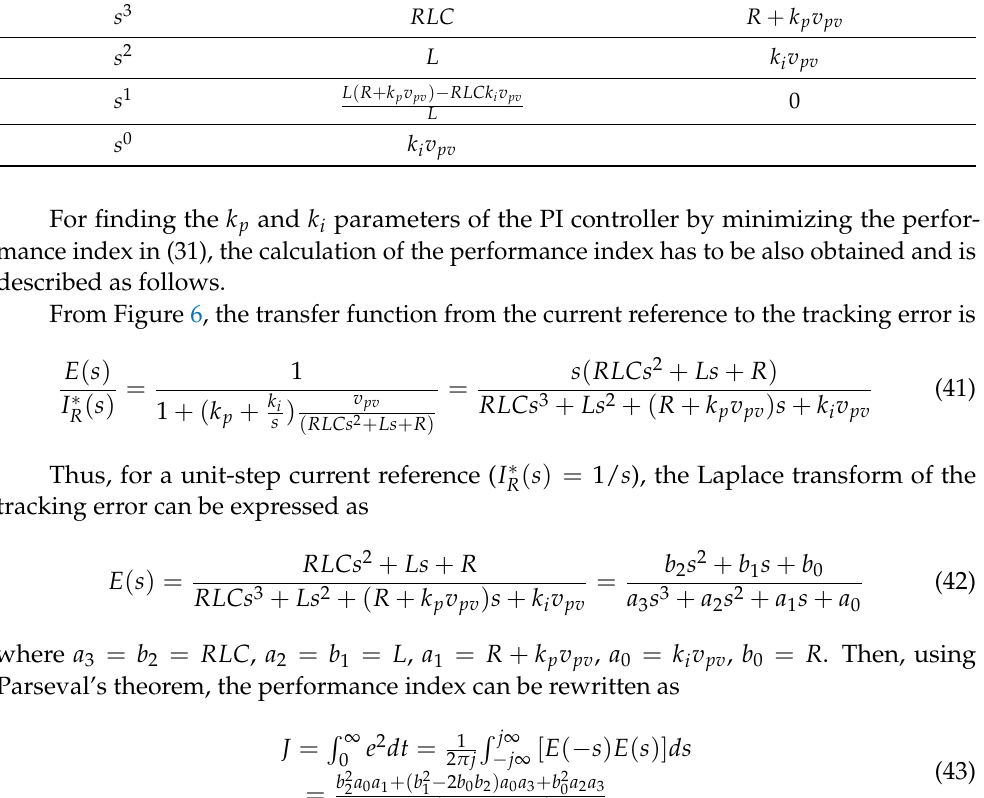
Table 1. The Routh’s tabulation. s